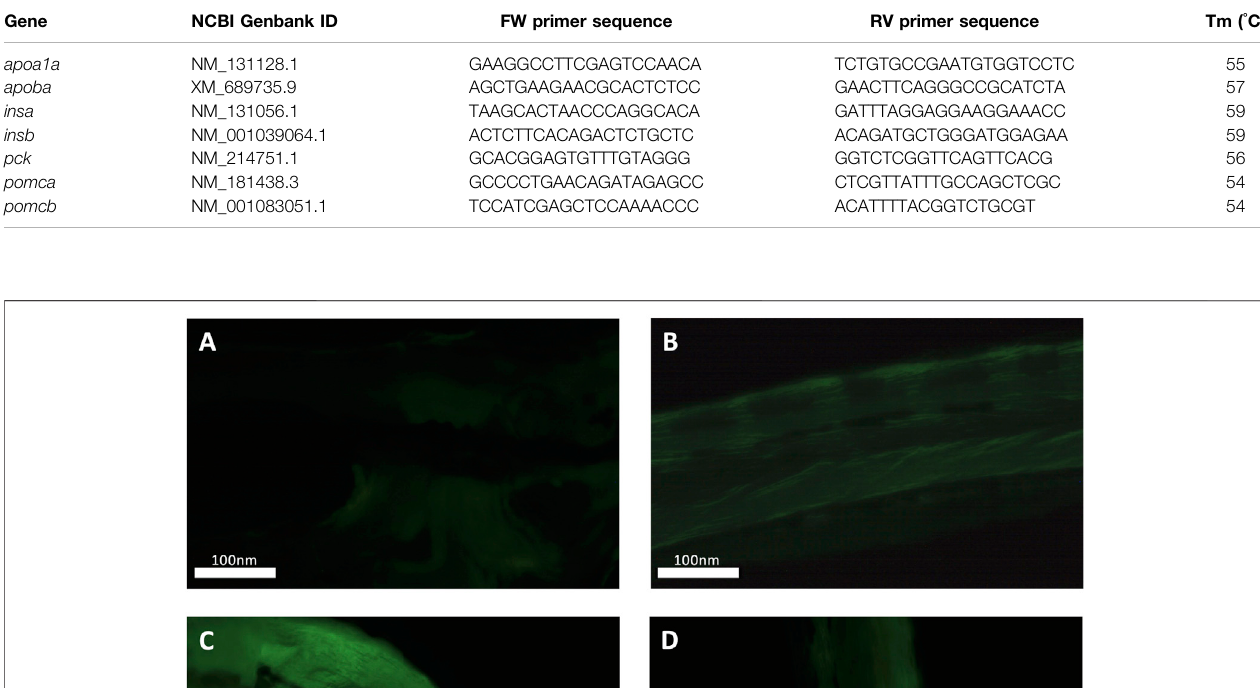
Frontiers in Pharmacology |